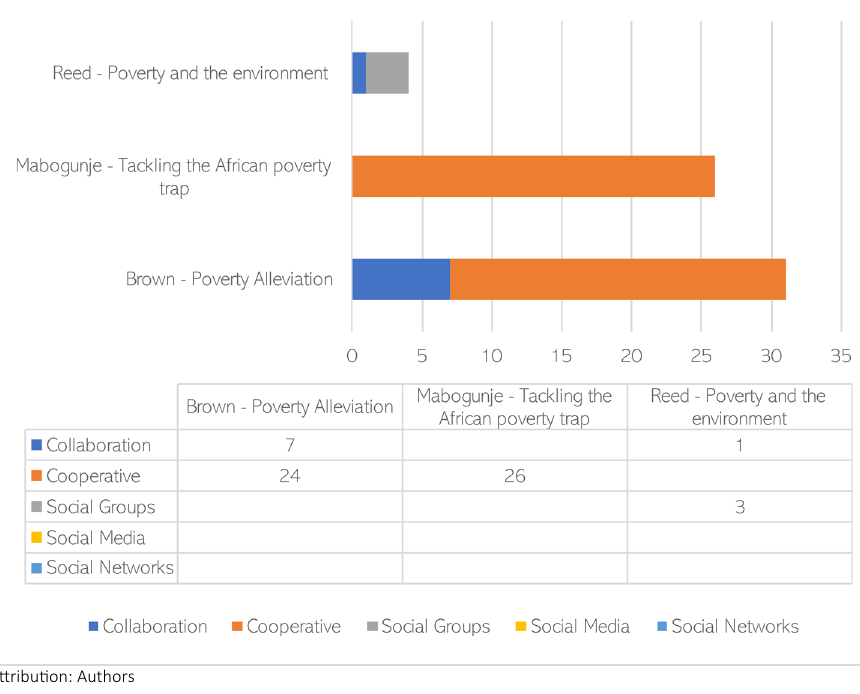
Fig. 11 Occurrences of Search